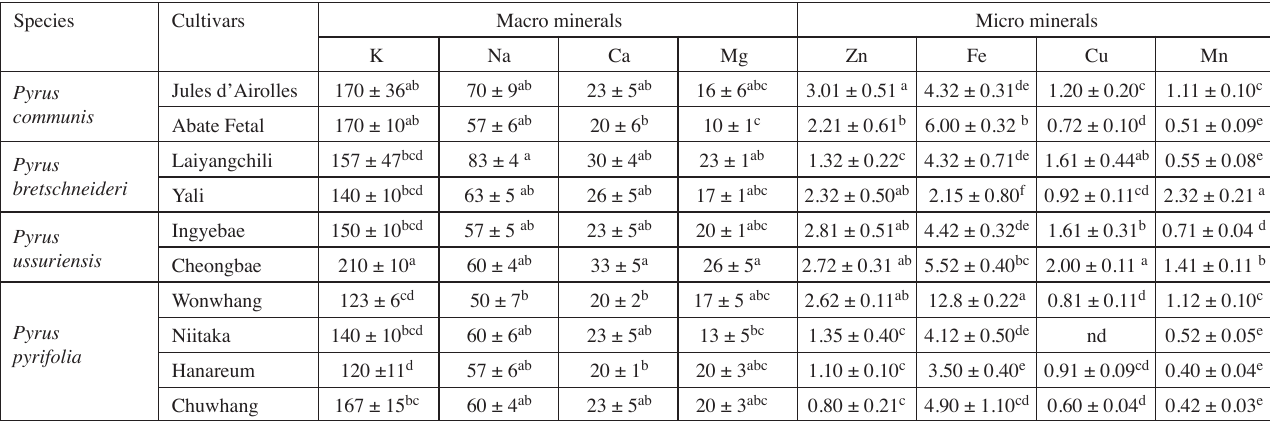
Tab. 4: Mineral compositions of 10 different pear cultivars (mg/100 g